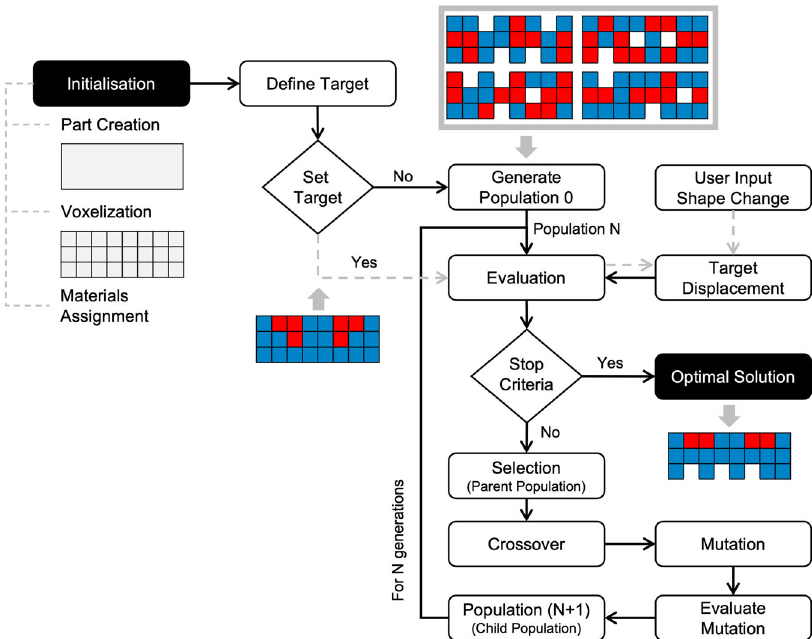
Fig. 5 Schematic fl owchart of the full design process drivenby an EA. By considering a voxel-based representation of a design space, the computational design process starts from a target shape (or displacement) and uses a FEA-based EA. It combines the advantages of optimizing both the materials distribution and material layout via TO to solve the inverse design problem of fi nding an optimal design to achieve a target shape by integrating void